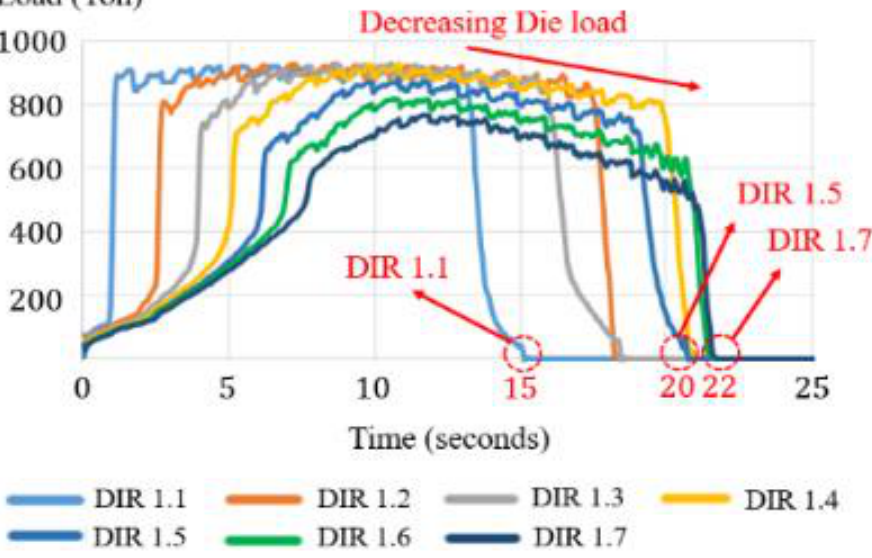
Figure 13. Forming time and load of the combined redrawing-ironing process.